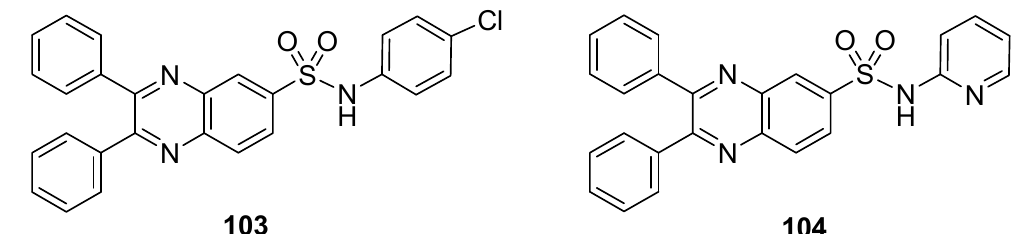
Figure 15. Substituted quinoxaline sulfonamide derivatives 103–104 .